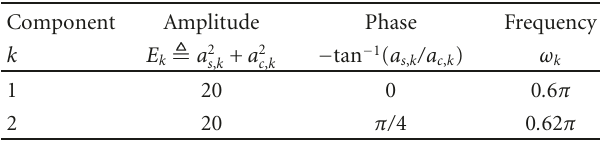
Table 1: Parameter settings for the simulated signalwith two closely spaced frequencies.